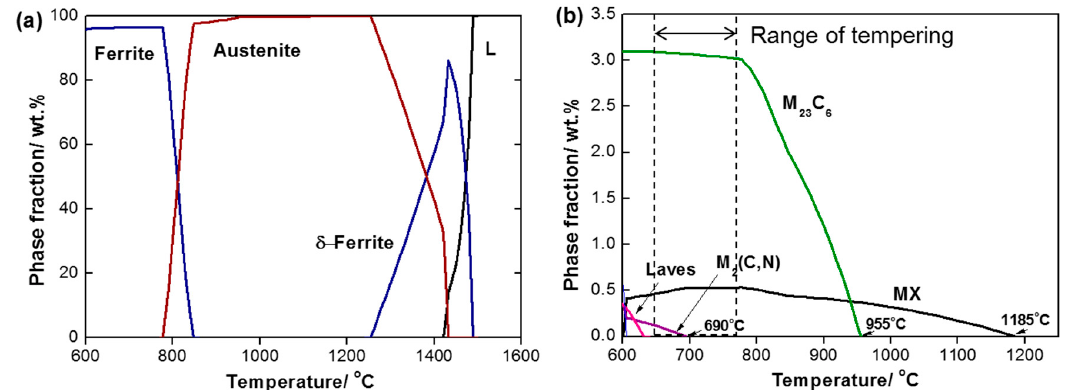
Figure 13. Relationship between phase fraction and temperature of 15Cr12MoVWN steel calculated by Thermo-Calc software based on the chemical composition in Table 1. ( a ): overall diagram; ( b ): partial diagram.